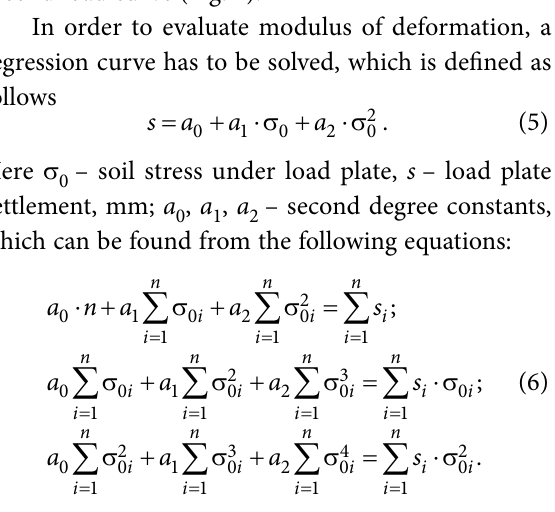
mm n t , m e e tt l S e